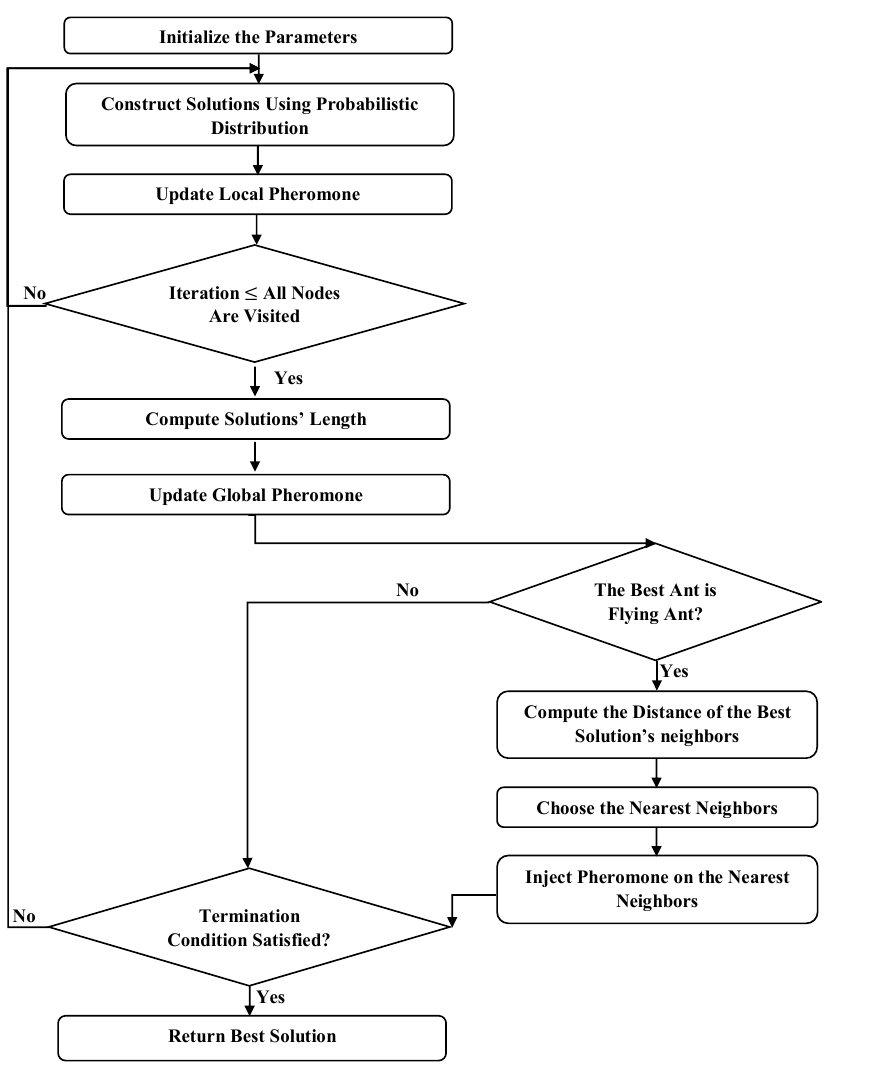
Figure 3. Flying ACO (FACO) flowchart.